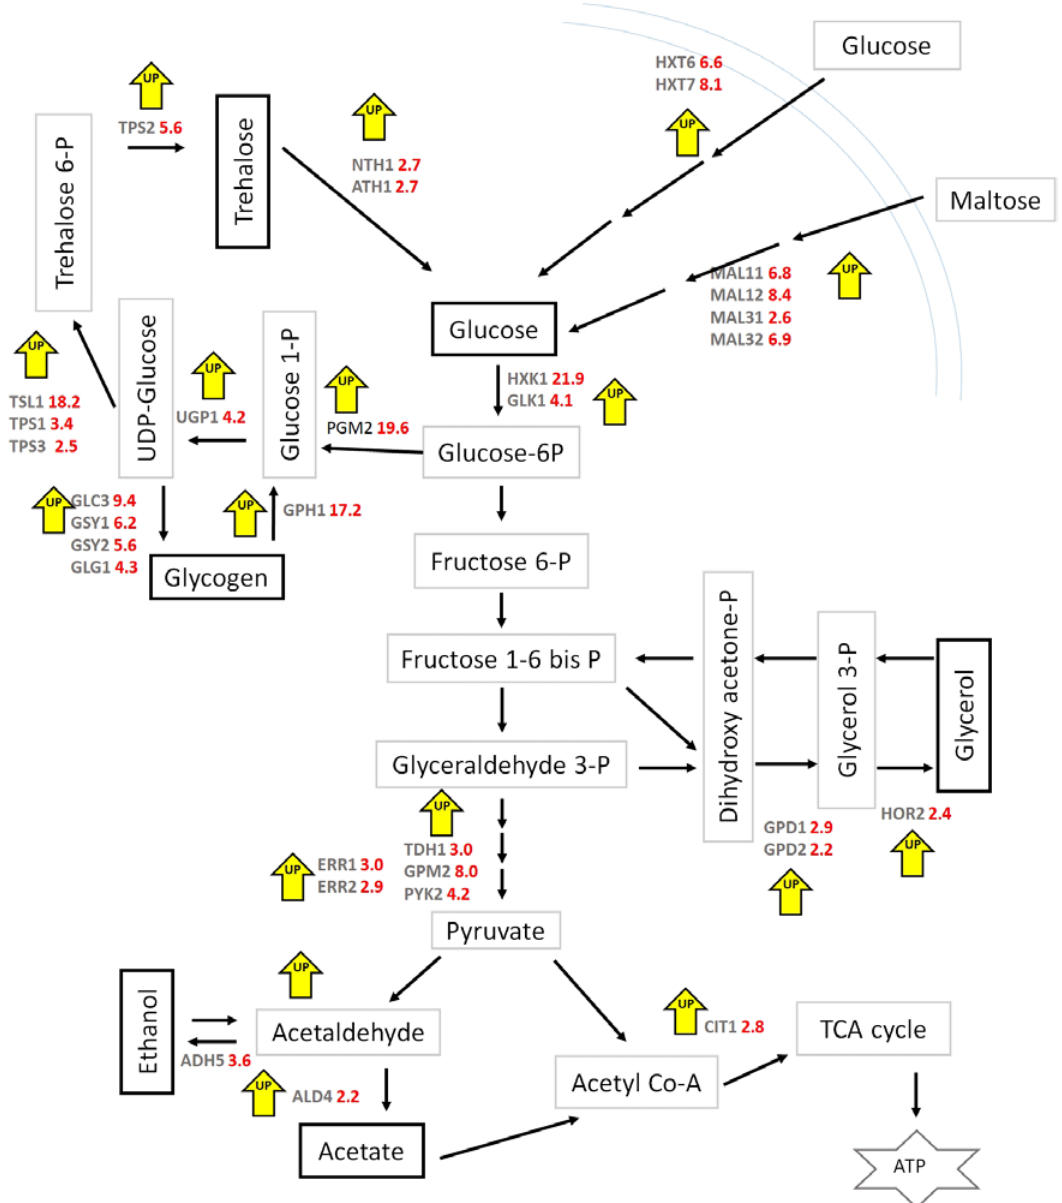
Figure 10. Upregulated genes in M8FE and their FC values as folds of 905 on the principal pathway of carbon metabolism (Figure was prepared by using the GeneSpring GX 12.0, Agilent Technologies-Wiki-pathway database [46]).